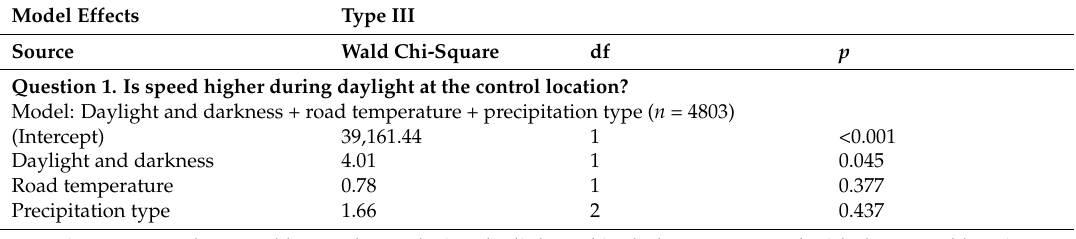
Table 2. Main results from the generalised linear models testing significance of the independent variables for the dependent variable (vehicle speed) for the different models (for more information see data analyses in materials and methods). Parameter estimates from the models are shown in Table 3. Hypothesis questions 1–4 are also shown in the table. D = Daylight and darkness, RT = Road temperature, P = Precipitation type. p = significance level, df = degrees of